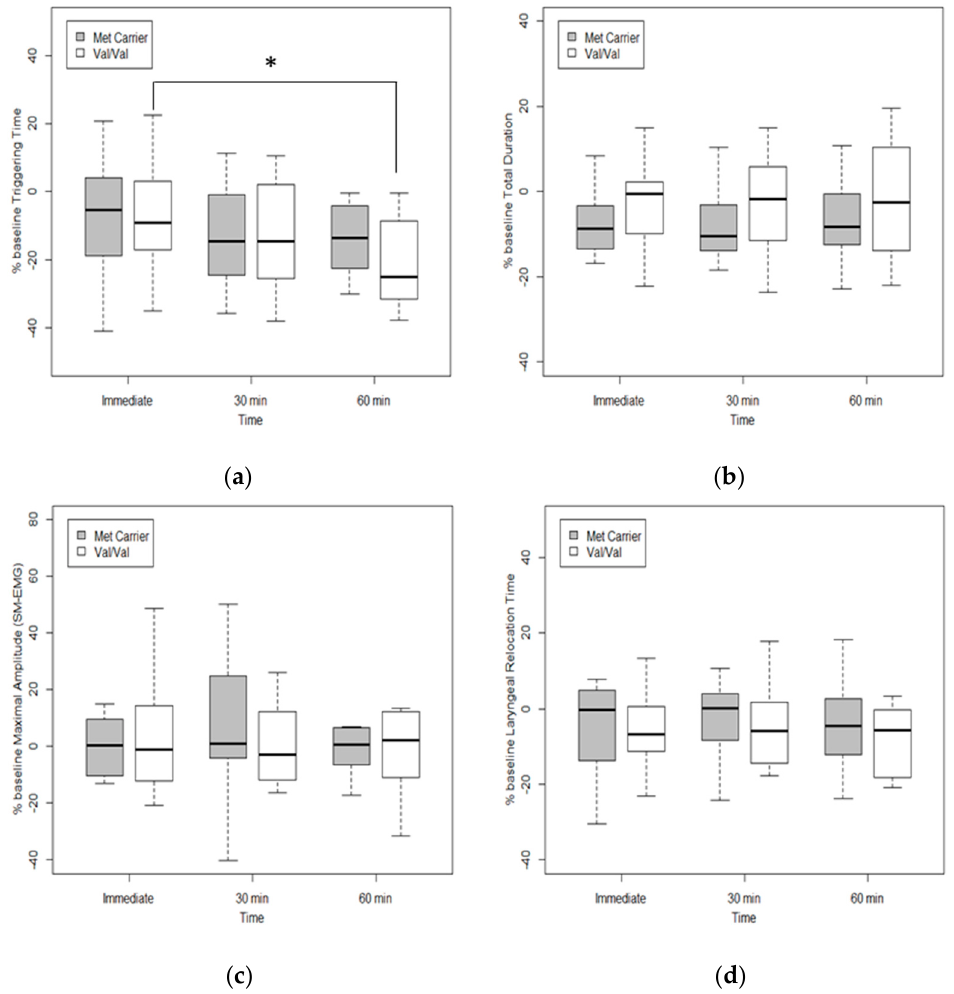
Figure 4. Swallowing function changes across time according to COMT polymorphism. ( a ) Percent changes of triggering time, ( b ) total duration, ( c ) maximal amplitude of submental-electromyography (SM-EMG), and ( d ) laryngeal relocation time from baseline. Friedman test was performed to assess changes across time of the response variables in Val/Val and Met carrier groups. Post hoc Wilcoxon signed-rank test in the Val/Val group showed statistically significant percentage changes from baseline in triggering time between immediate and 60 min after tDCS (adjusted p -value = 0.01). Statistically significant time interval differences are indicated by a solid line and an asterisk (*).